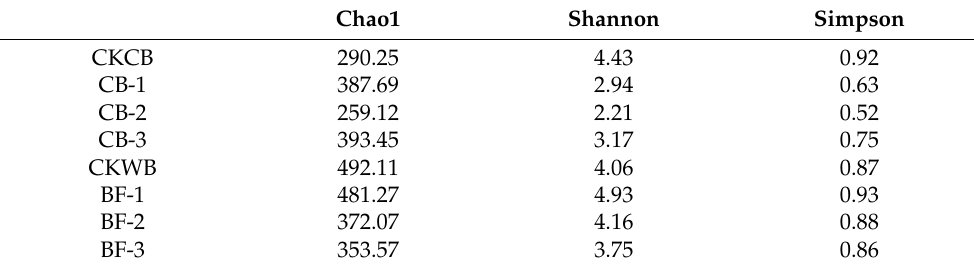
Table 2. The alpha diversity index of biofloc from both reactors based on the 18S rRNA sequences. Chao1 Shannon